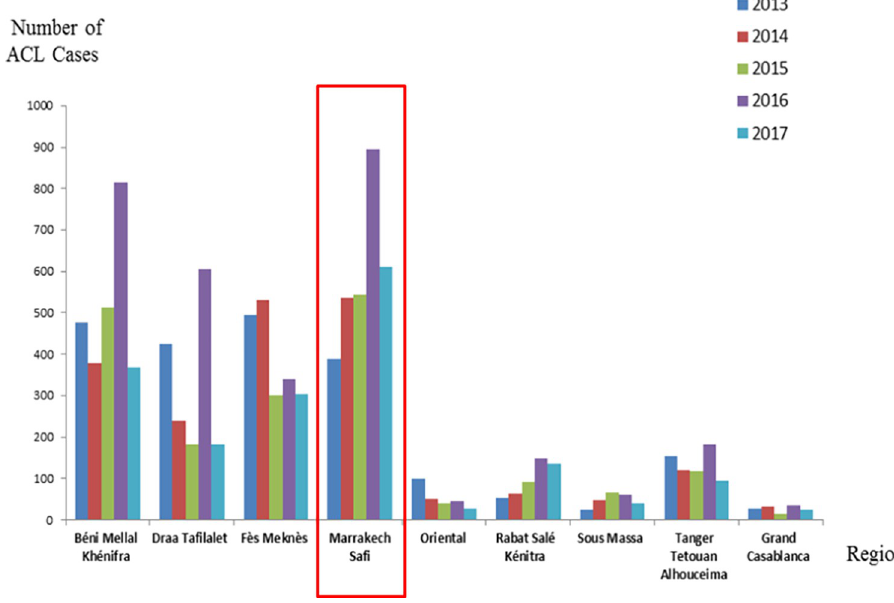
Fig 2. Distribution of ACL cases in Morocco by endemic region between 2013 and 2017 according to data reported by National Ministry of Health [13].